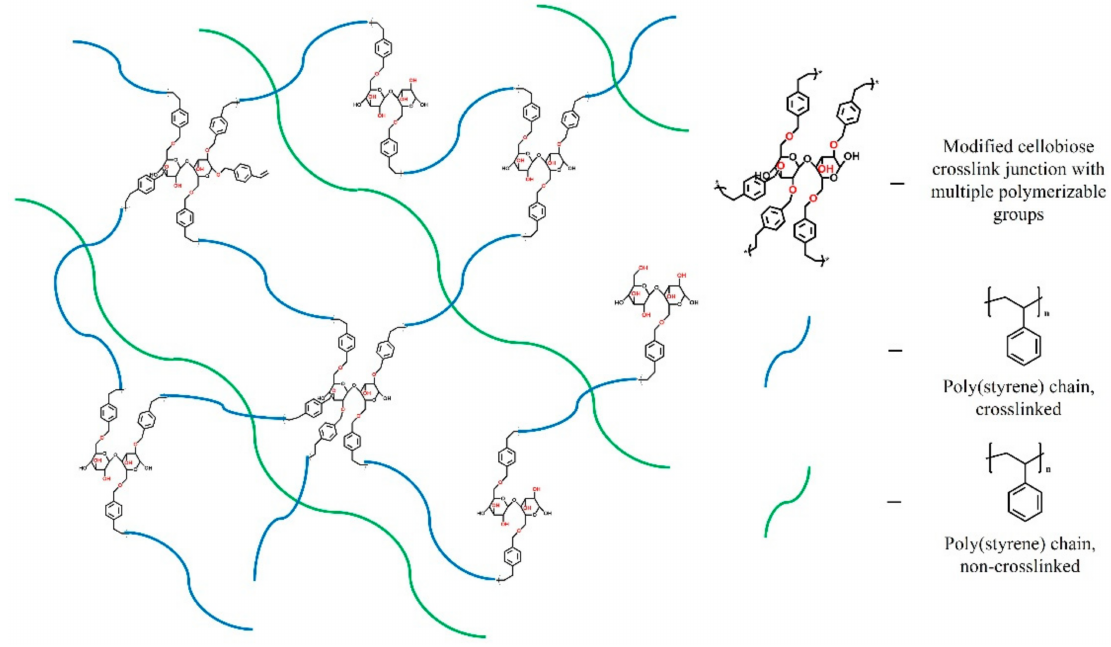
Figure 1. Schematic representation of PSt semi-interpenetrating network formed by copolymerization of modified cellobiose and